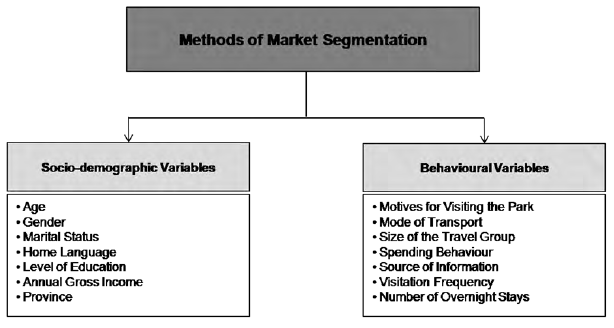
Figure 1: Market segmentation by means of socio- demographic & behavioural